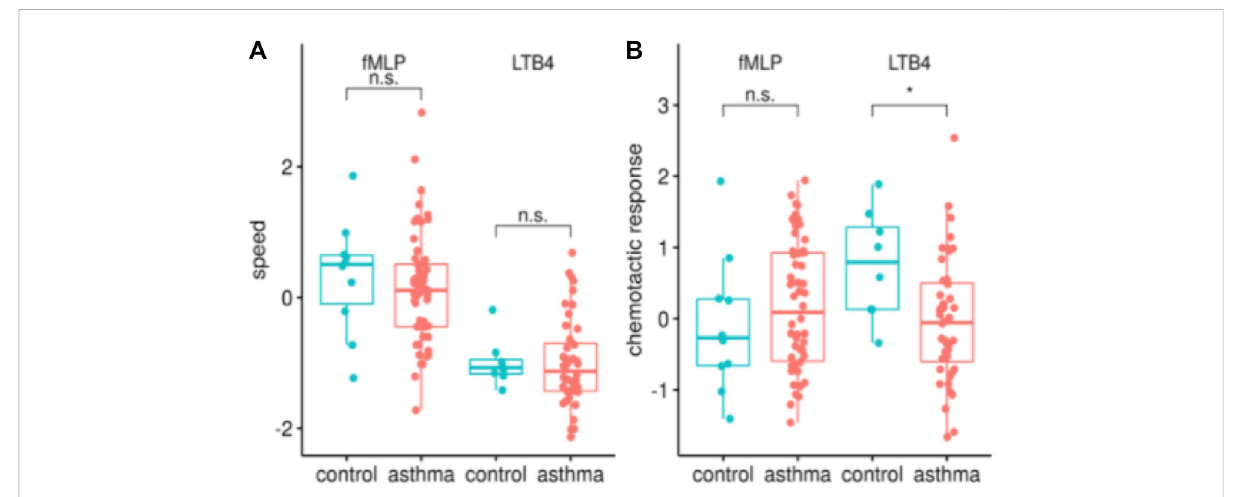
FIGURE 2 AsthmapatientshaveareducedchemotacticresponsetowardsLTB4,intermsofpercentageofNGsmovingasopposedtoaveragespeed.The analysis of the SiMA chemotaxis assays is characterized using the two most telling migration parameters, speed [z-value, in (A) ] and chemotactic response [z-value, in (B) ] for all migrations towards fMLP and LTB4. The distribution is shown for healthy controls ( n = 10/8 fMLP/LTB4) and asthma patients ( n = 55/45 for fMLP/LTB4). Migration parameters show a signi fi cantly reduced chemotactic response of asthma patients towards LTB 4 ( p <